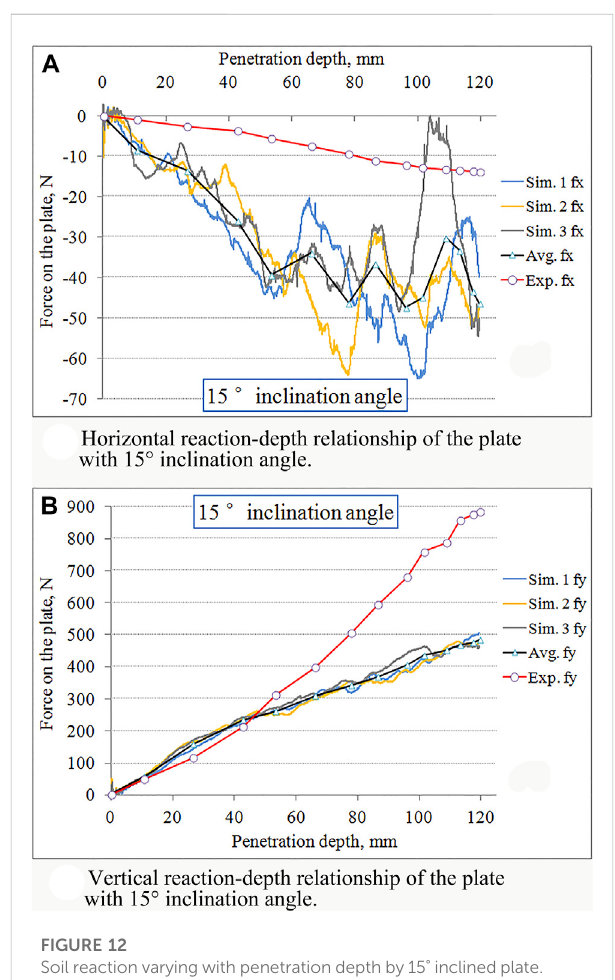
FIGURE 12 Soil reaction varying with penetration depth by 15 ° inclined plate. (A) Horizontal reaction-depth relationship of the plate with 15 ° inclination angle. (B) Vertical reaction-depth relationship of the plate with 15 ° inclination